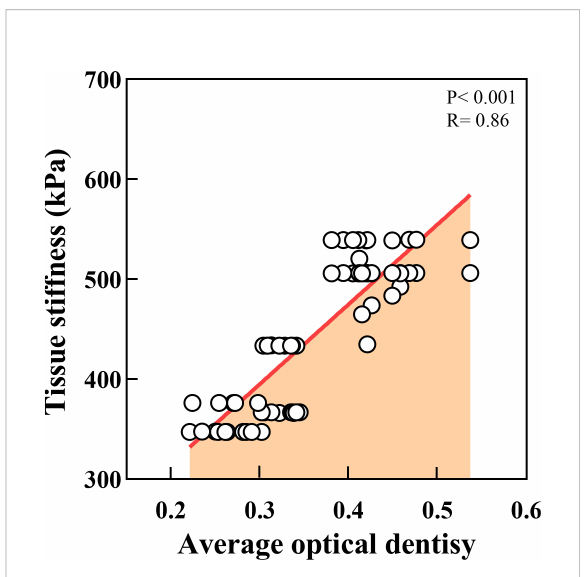
FIGURE 9 Correlation analysis between tissue stiffness of OSCC and PCNP expression. (P < 0.001, R =